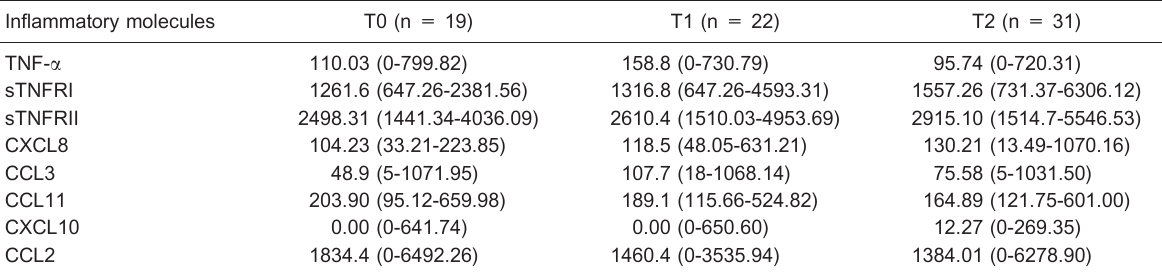
Table 2. Median plasma levels of inflammatory molecules measured at different times in the entire population of neutropenic patients. Inflammatory